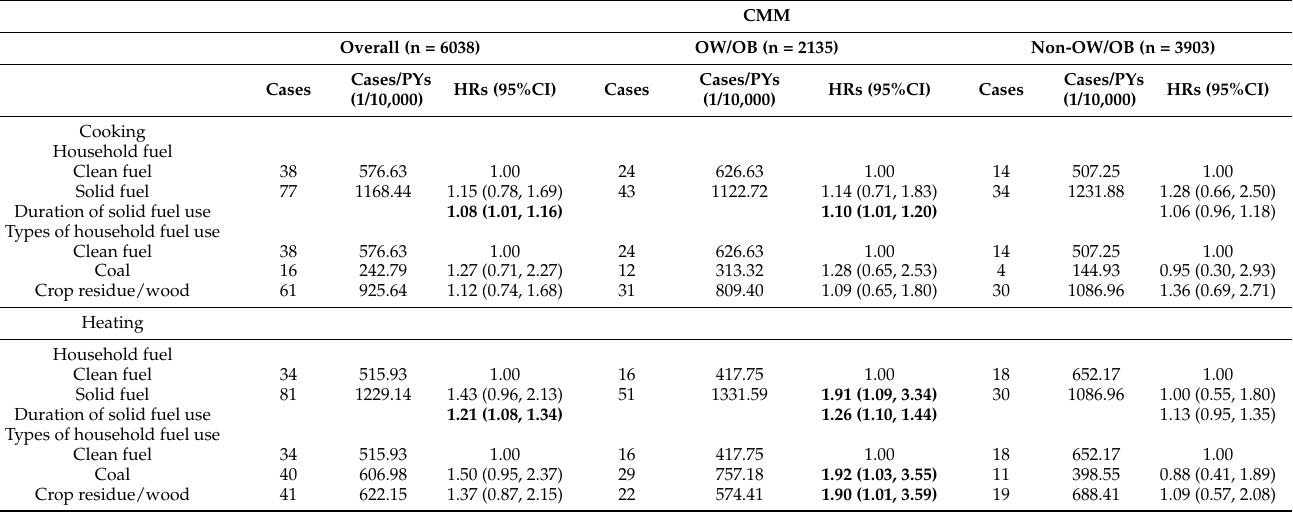
Note: CMM, cardiometabolic multimorbidity; HR, hazard ratio; CI, confidence interval; PYs, person years. CMD includes heart disease, stroke, and T2D. CMM is defined as occurrence at least two of the above-mentioned diseases. Multivariable models were adjusted for age, gender, marital status, education level, residence, smoking, and alcohol consumption. p values < 0.05 are bold. The interaction effect between household solid fuel and OW/OB on the incidence of CMD and CMM is shown in Table 4. Participants were divided into four subgroups by fuel usage (cooking or heating) and OW/OB (yes or no). Compared with the participants who used clean fuel for cooking and without OW/OB, the incident risk of CMD and CMM was higher in those using solid fuel and with OW/OB (HR = 2.05, 95% CI: 1.67, 2.51 for CMD; HR = 3.16, 95% CI: 1.76, 5.67 for CMM), those using clean fuel and with